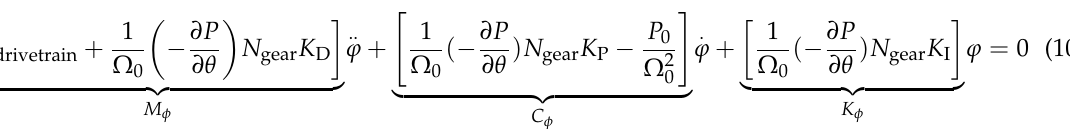
the rotor speed error.